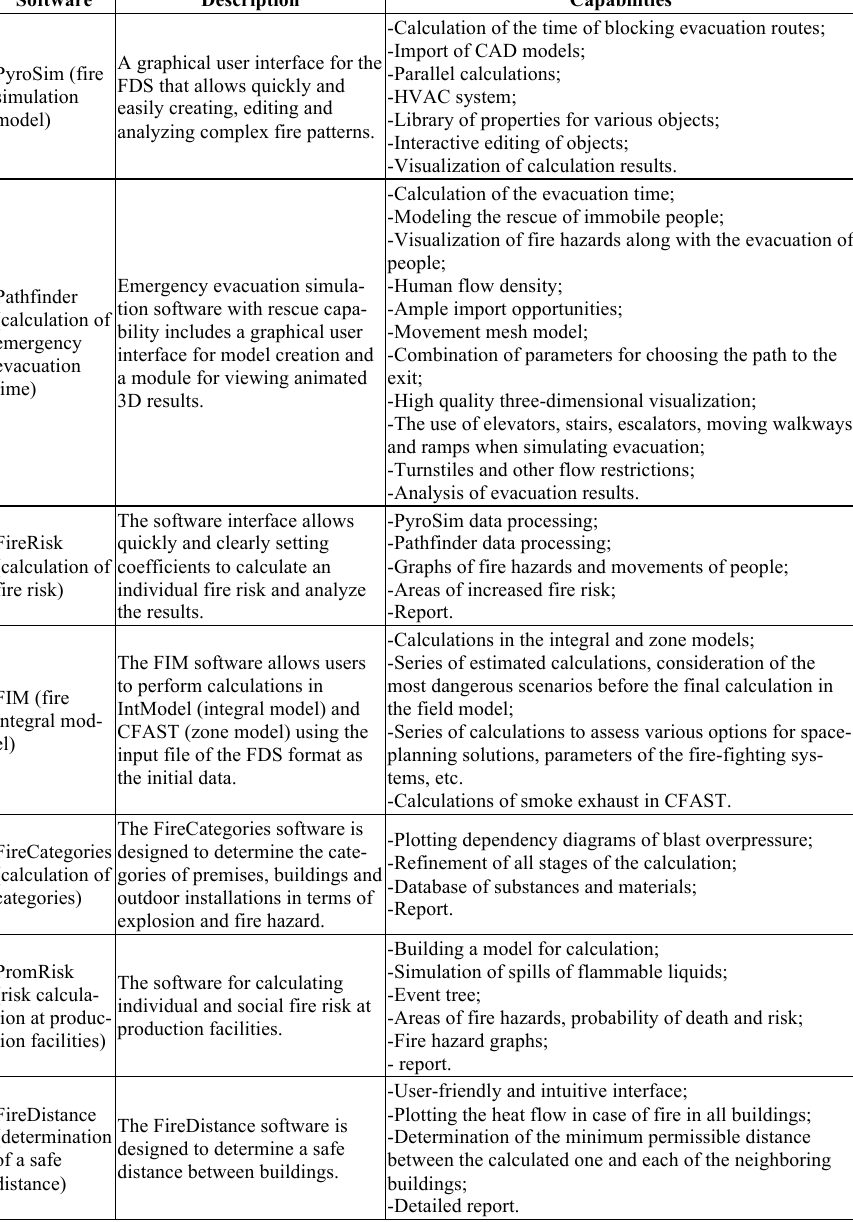
Table 2. Fire safety software included in the educational